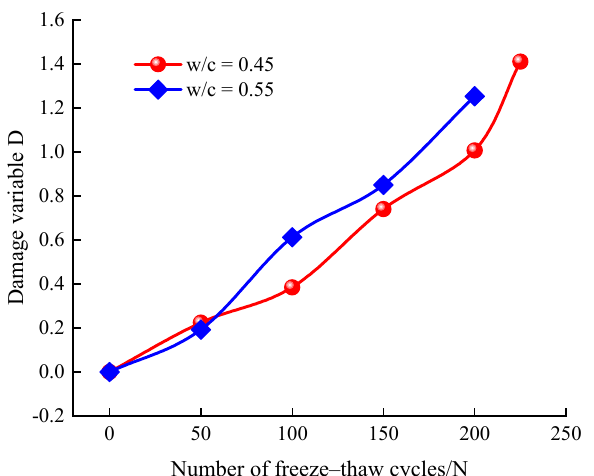
Figure 20. Relationship between damage variable D of concrete specimens and freeze–thaw cycles.